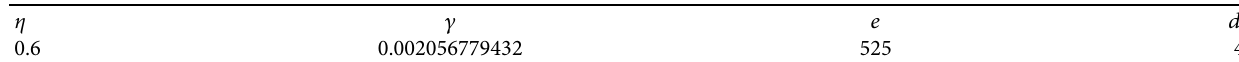
Table 4: The parameters set in system (4).